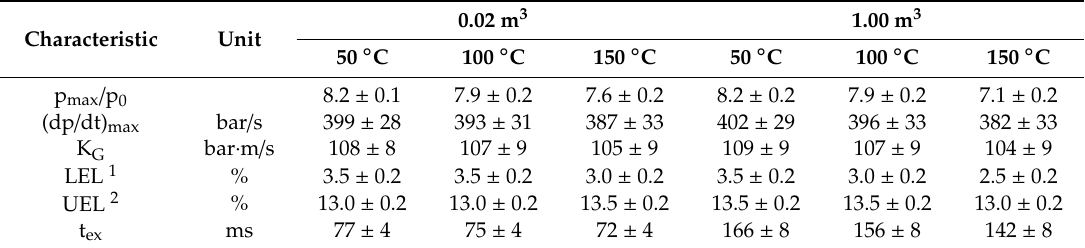
Table 5. 1-propanol / 2-propanol–air mixture explosion characteristics at Φ = 1.06, p 0 = 100 kPa.